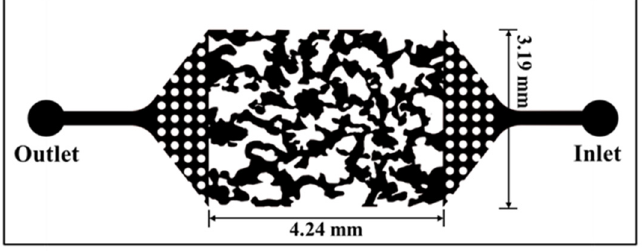
Figure 4. Schematic diagram of the microscopic model.